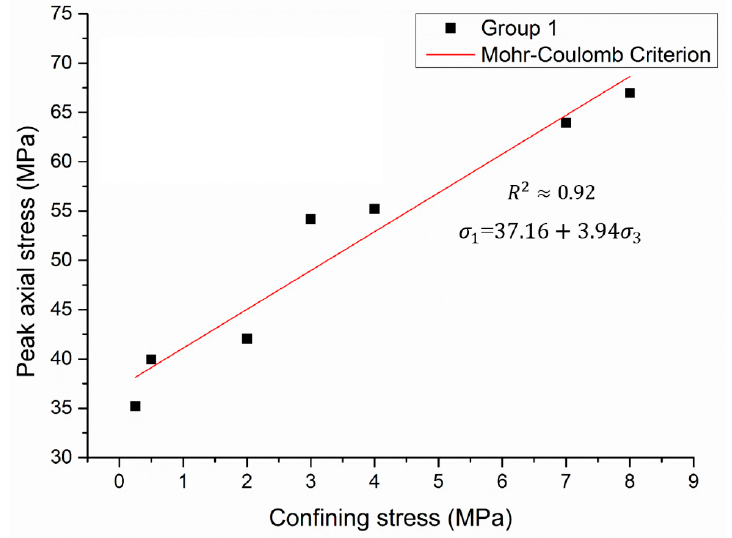
Figure 10. Strength property for Mohr-Coulomb failure criterion based on the peak axial stress at failure.